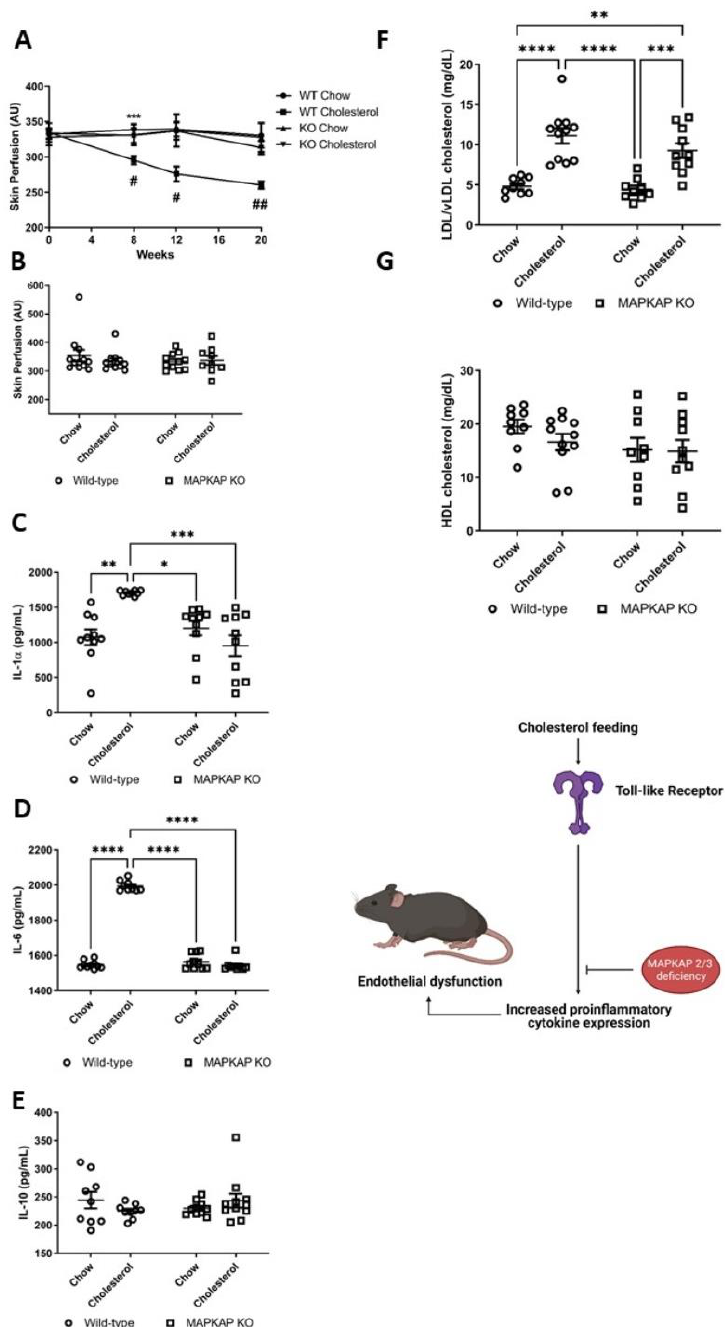
Figure 6. Microvascular responses in MAPKAP2/3 knockout and wild-type mice. ( A ) Endothelium- dependent micro-vascular responses in arbitrary units (AU) over 20 weeks and ( B ) terminal endothelium-independent in wild-type (WT)-chow ( n = 17), WT-cholesterol ( n = 12), MAPKAP knock-out (KO)-chow ( n = 11) and MAPKAP KO-cholesterol ( n = 13) fed animals. Longitudinal changes were analysed by ANOVA for repeated measures followed by post-hoc Bonferroni correction. ( A , B ) *** p < 0.001 comparing genotypes, # p < 0.05, ## p < 0.01 comparing diet. Plasma cytokines (pg/mL) ( C ) IL-1 α , ( D ) IL-6, and ( E ) IL-10 in WT-chow ( n = 10), WT-cholesterol. ( n = 10), MAPKAP KO-chow ( n = 10) and MAPKAPKO-cholesterol fed ( n = 10) mice. Plasma measurements of ( F ) low density lipoproteins and very low-density lipoproteins (LDL/vLDL) and ( G ) high density lipopro- teins (HDL) in the plasma of WT-chow ( n = 10), WT-cholesterol ( n = 9), MAPKAP KO-chow ( n = 9) and MAPKAP KO-cholesterol fed mice ( n = 10) (mg/dL). ( C – G ) two-way ANOVA values are group means ± SE. * p < 0.05, ** p < 0.01, *** p < 0.001, **** p <